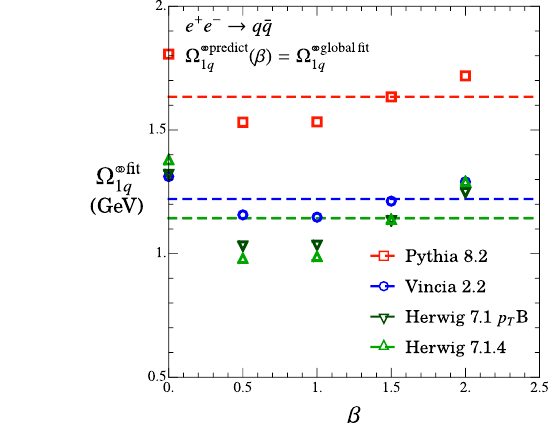
by (cid:12)tting for individual z cut and (cid:12) values and 1 q for Herwig are the same for both 1 q